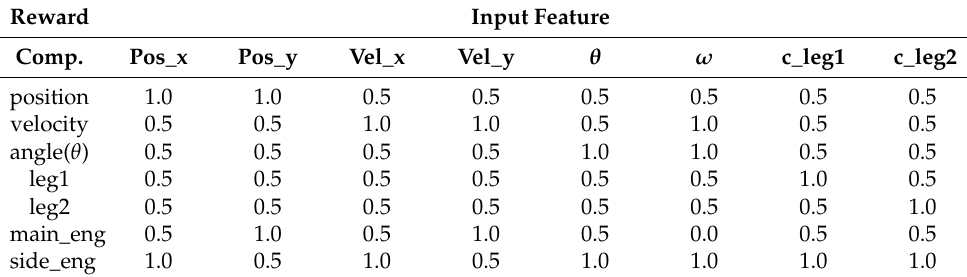
Table A8. Relevance table for the Lunarlander agent. Reward Input Feature